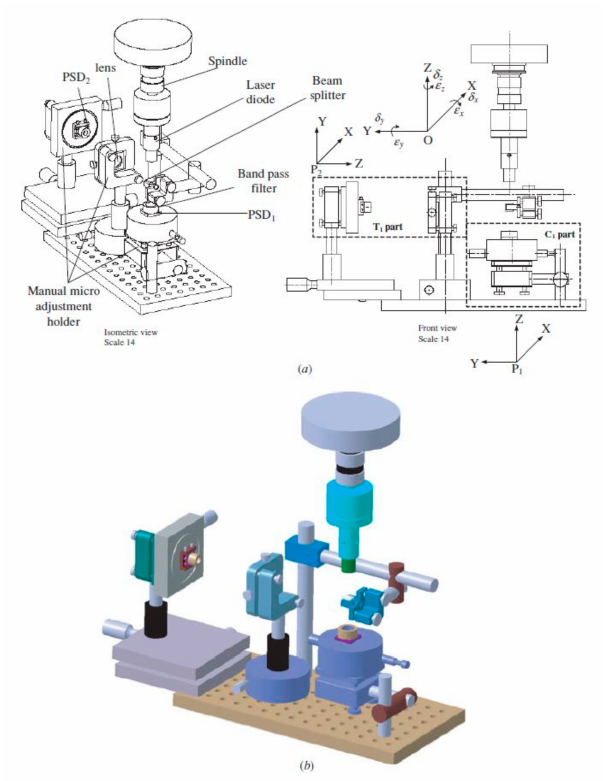
Figure 29. The prototype design and coordinate definition of the developed test device: ( a ) the schematic plot and coordinate definition, ( b ) the 3D prototype design